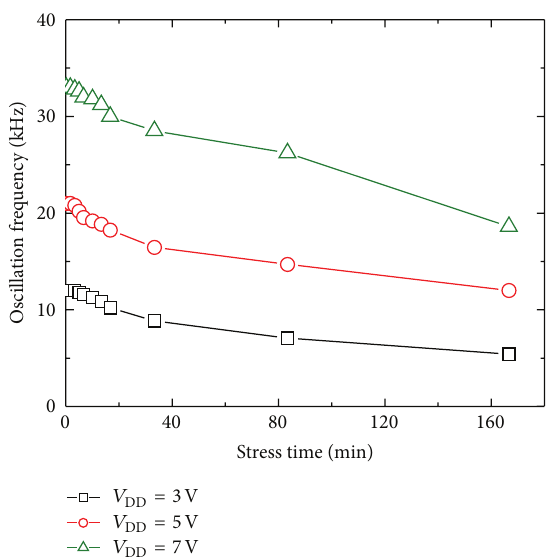
beam lithography have been demonstrated elsewhere, and the same process could be extended to produce compact